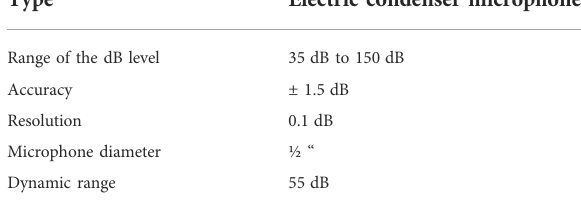
TABLE 3 Speci fi cation of the particulate matter emission measuring device.